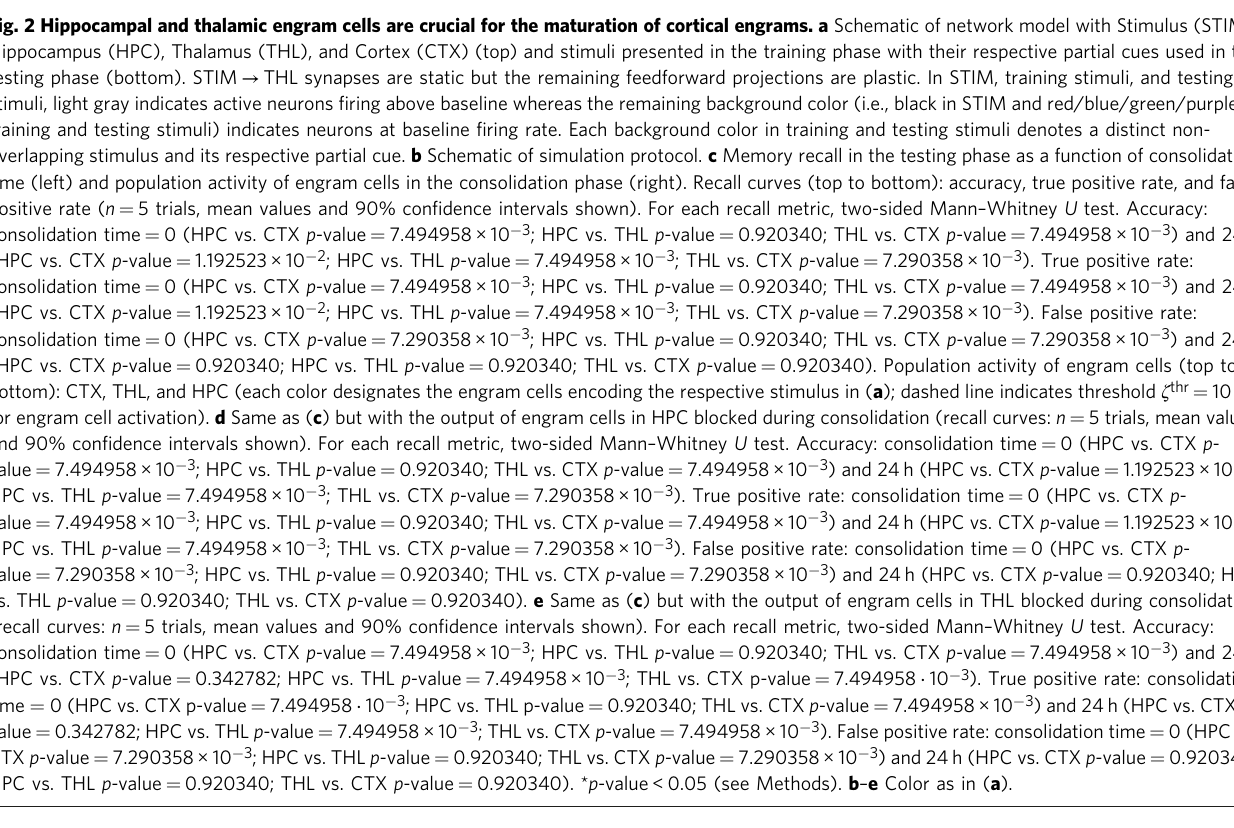
Fig. 2 Hippocampal and thalamic engram cells are crucial for the maturation of cortical engrams. a Schematic of network model with Stimulus (STIM), Hippocampus (HPC), Thalamus (THL), and Cortex (CTX) (top) and stimuli presented in the training phase with their respective partial cues used in the testing phase (bottom). STIM → THL synapses are static but the remaining feedforward projections are plastic. In STIM, training stimuli, and testing stimuli, light gray indicates active neurons fi ring above baseline whereas the remaining background color (i.e., black in STIM and red/blue/green/purple in training and testing stimuli) indicates neurons at baseline fi ring rate. Each background color in training and testing stimuli denotes a distinct non- overlapping stimulus and its respective partial cue. b Schematic of simulation protocol. c Memory recall in the testing phase as a function of consolidation time (left) and population activity of engram cells in the consolidation phase (right). Recall curves (top to bottom): accuracy, true positive rate, and false positive rate ( n = 5 trials, mean values and 90% con fi dence intervals shown). For each recall metric, two-sided Mann – Whitney U test. Accuracy: consolidation time = 0 (HPC vs. CTX p -value = 7.494958× 10 − 3 ; HPC vs. THL p -value = 0.920340; THL vs. CTX p -value = 7.494958 × 10 − 3 ) and 24